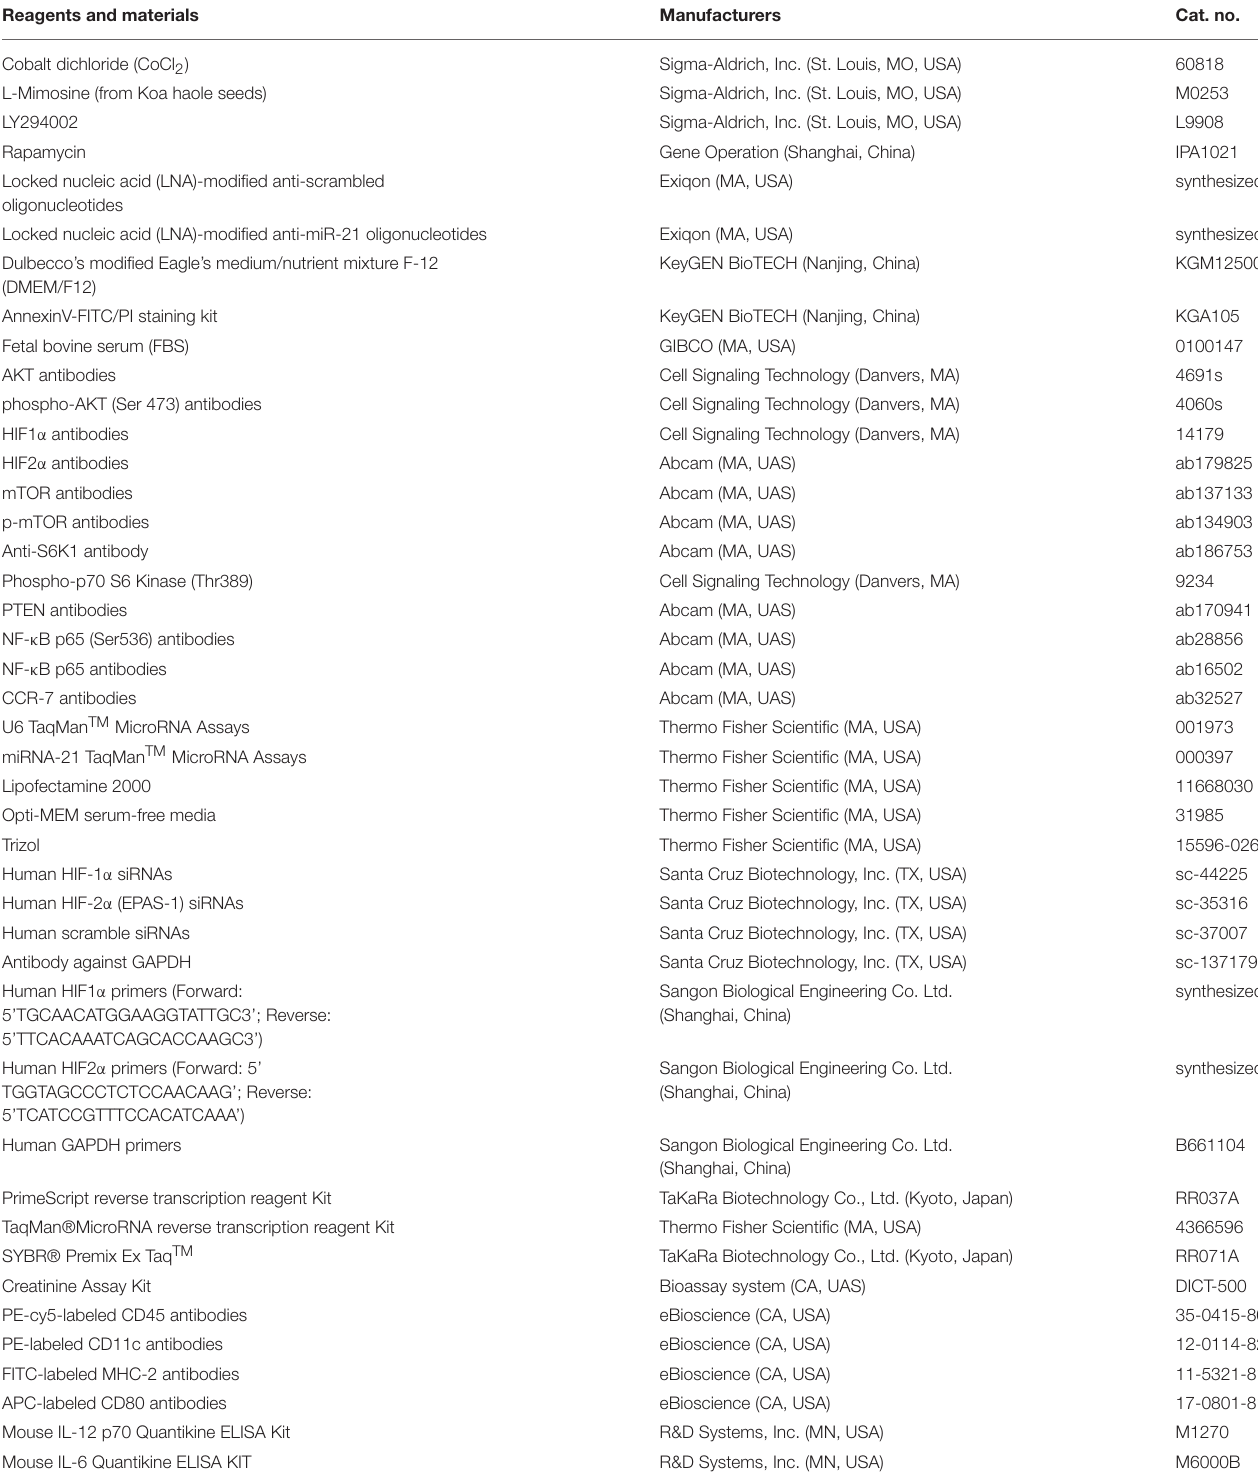
TABLE 1 | Reagents and materials. Reagents and